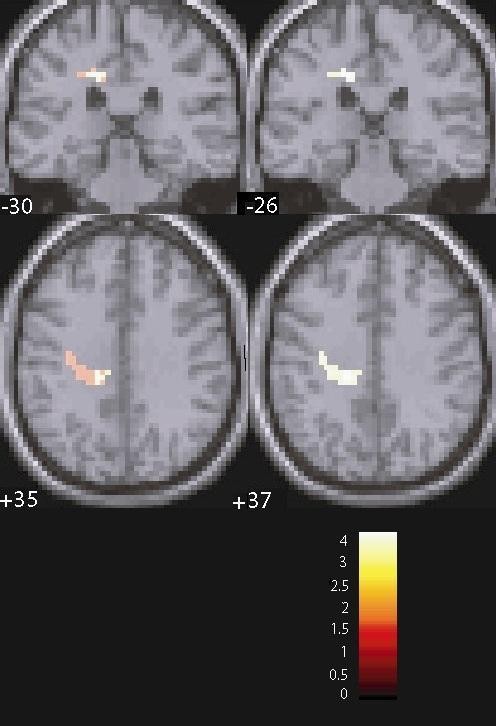
Coronal and axial sections displaying activation differences between major depressive disorder (MDD) patients and healthy controls (HC) in the left middle cingulum (T = 3.82, PFWE = 0.041) and left insula (T = 4.19, P < 0.001, uncorrected). FWE: whole brain family-wise error correction.